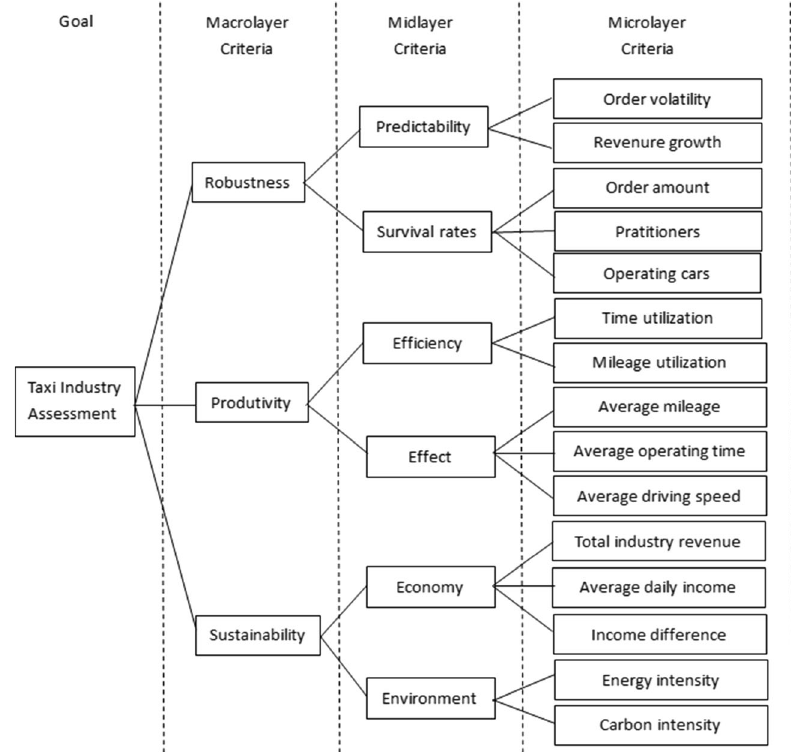
Fig. 4 Criteria set of taxi industry ’ s evaluation